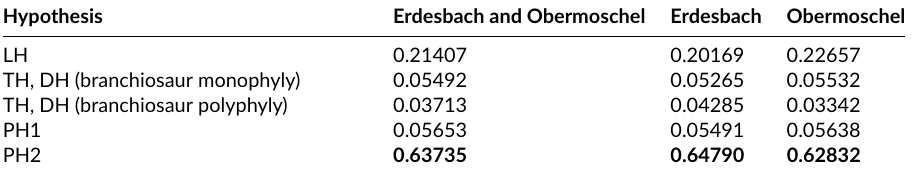
Table 9 – Effect of the intraspecific variability in ossification sequences of Apateon